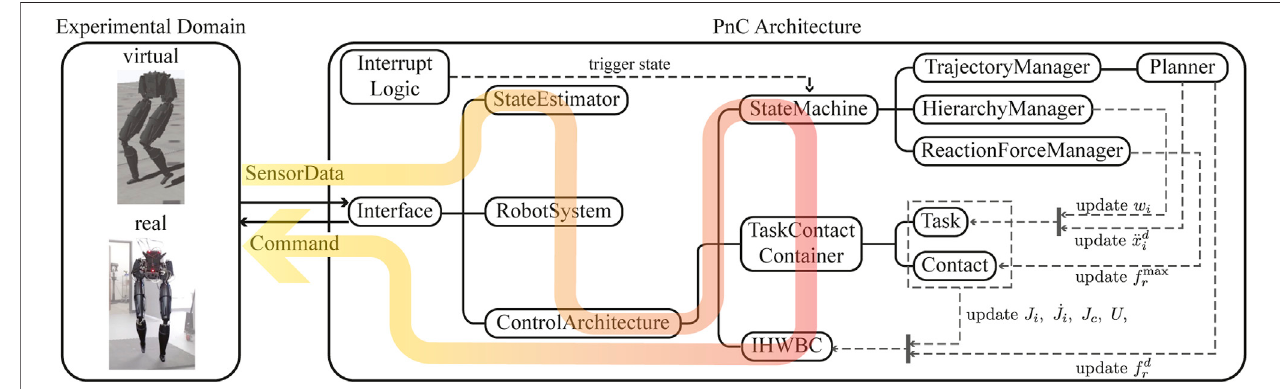
FIGURE5| ThePnC software architectureispresented withthecomputation fl ow andthe individualclass objects. PnCcommunicateswithaphysicssimulator or the real robot hardware via the Interface class by receiving the robot ’ s information and returning a command. Internally, PnC estimates the robot ’ s states, and solves forward kinematics and dynamics using a rigid body dynamics library. Manager blocks update the task hierarchy weights, desired task accelerations, and the reaction force upper bounds based on fi nite state machines, which will then be used in the IHWBC module to compute the target joint positions, velocities, and torque